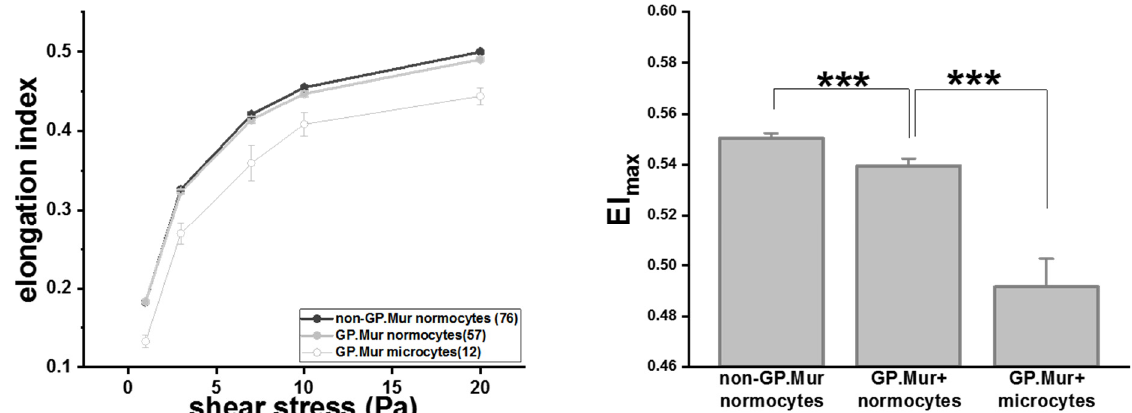
Figure 2. GP.Mur+ RBCs were less deformable than non-GP.Mur RBCs and GP.Mur+ microcytes were least deformable compared to normocytes. Left: The elongation indices increased as the given shear stresses increased. The number of subjects tested per group is indicated in the parentheses in the legend box. Right: All three groups were significantly different from one another; *** p < 0.001.